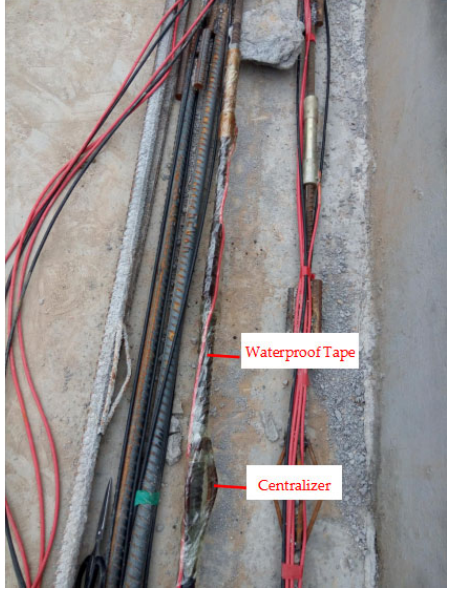
Figure 7. The manufactured testing anchors.